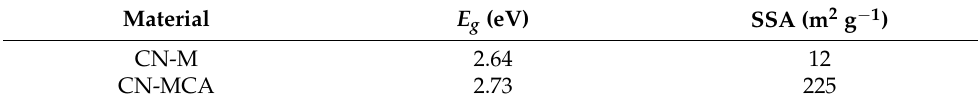
Table 2. Band gap energy and specific surface area of CN